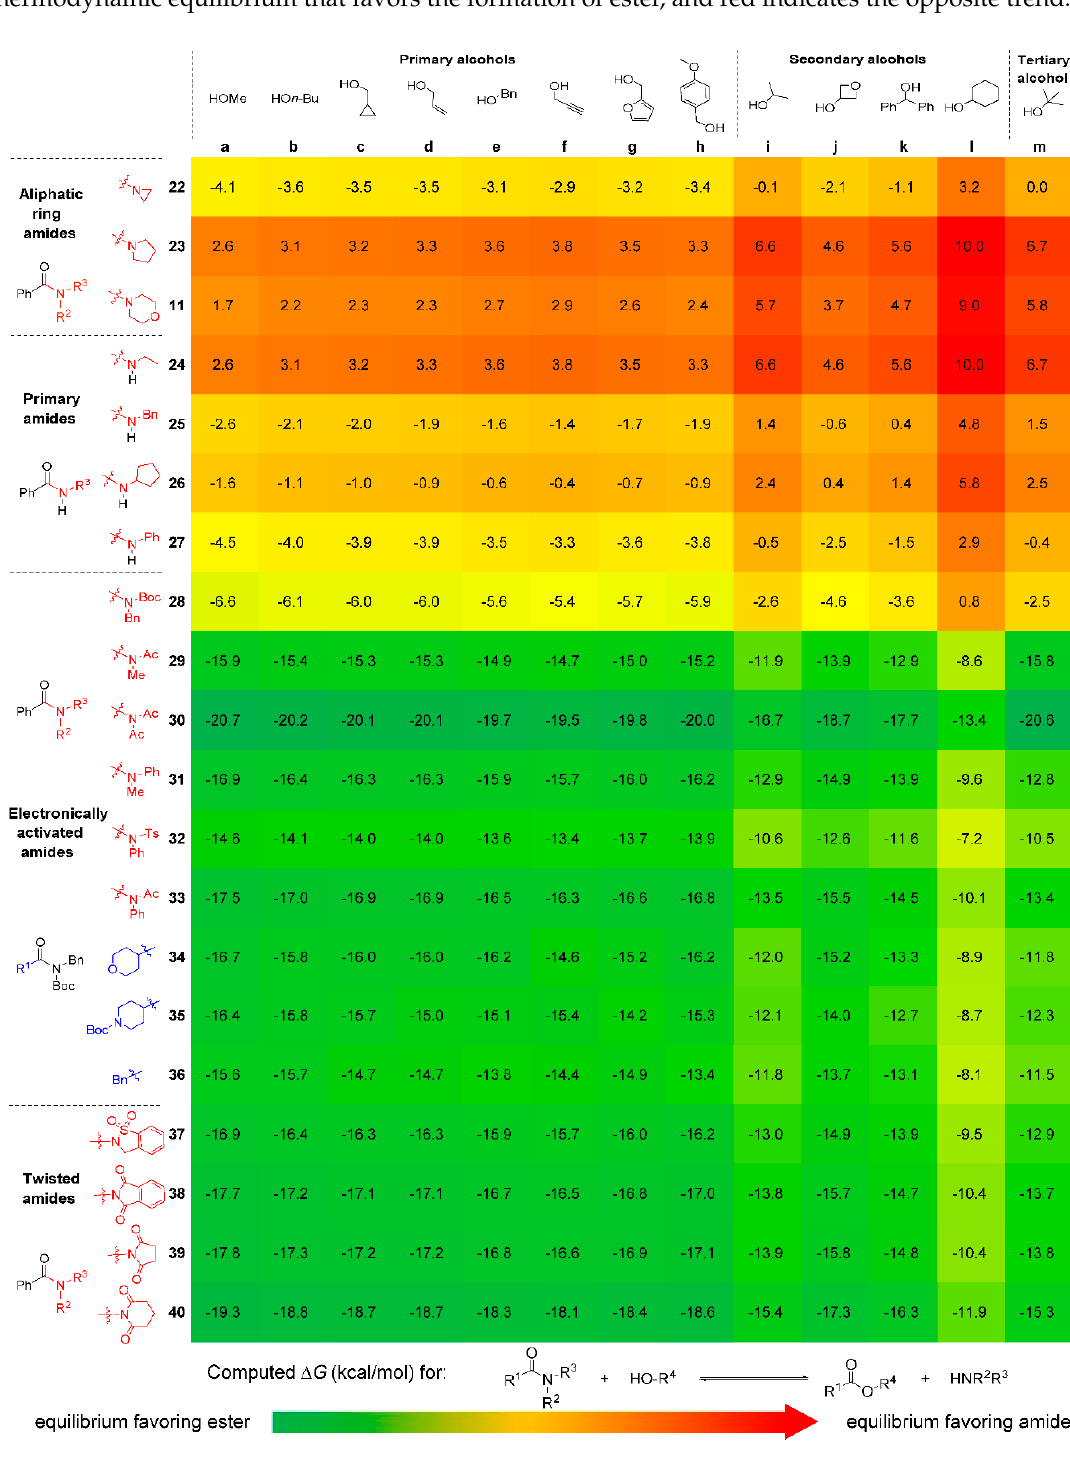
Figure 5. DFT-computed thermodynamics of esterification of amides.